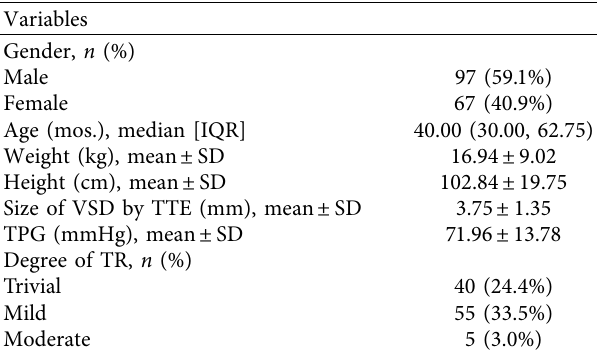
Table 1: Patient